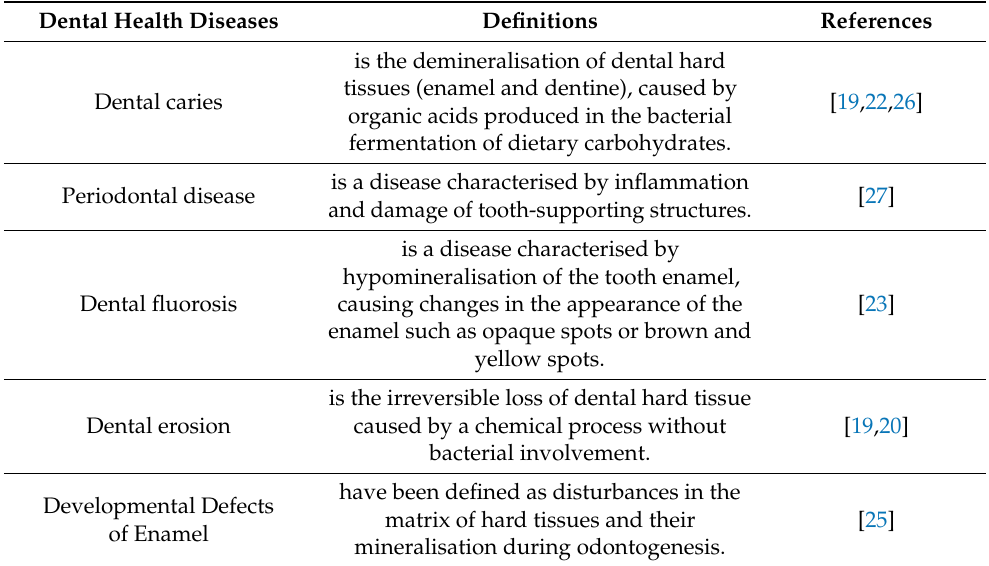
Table 1. Definitions of dental health